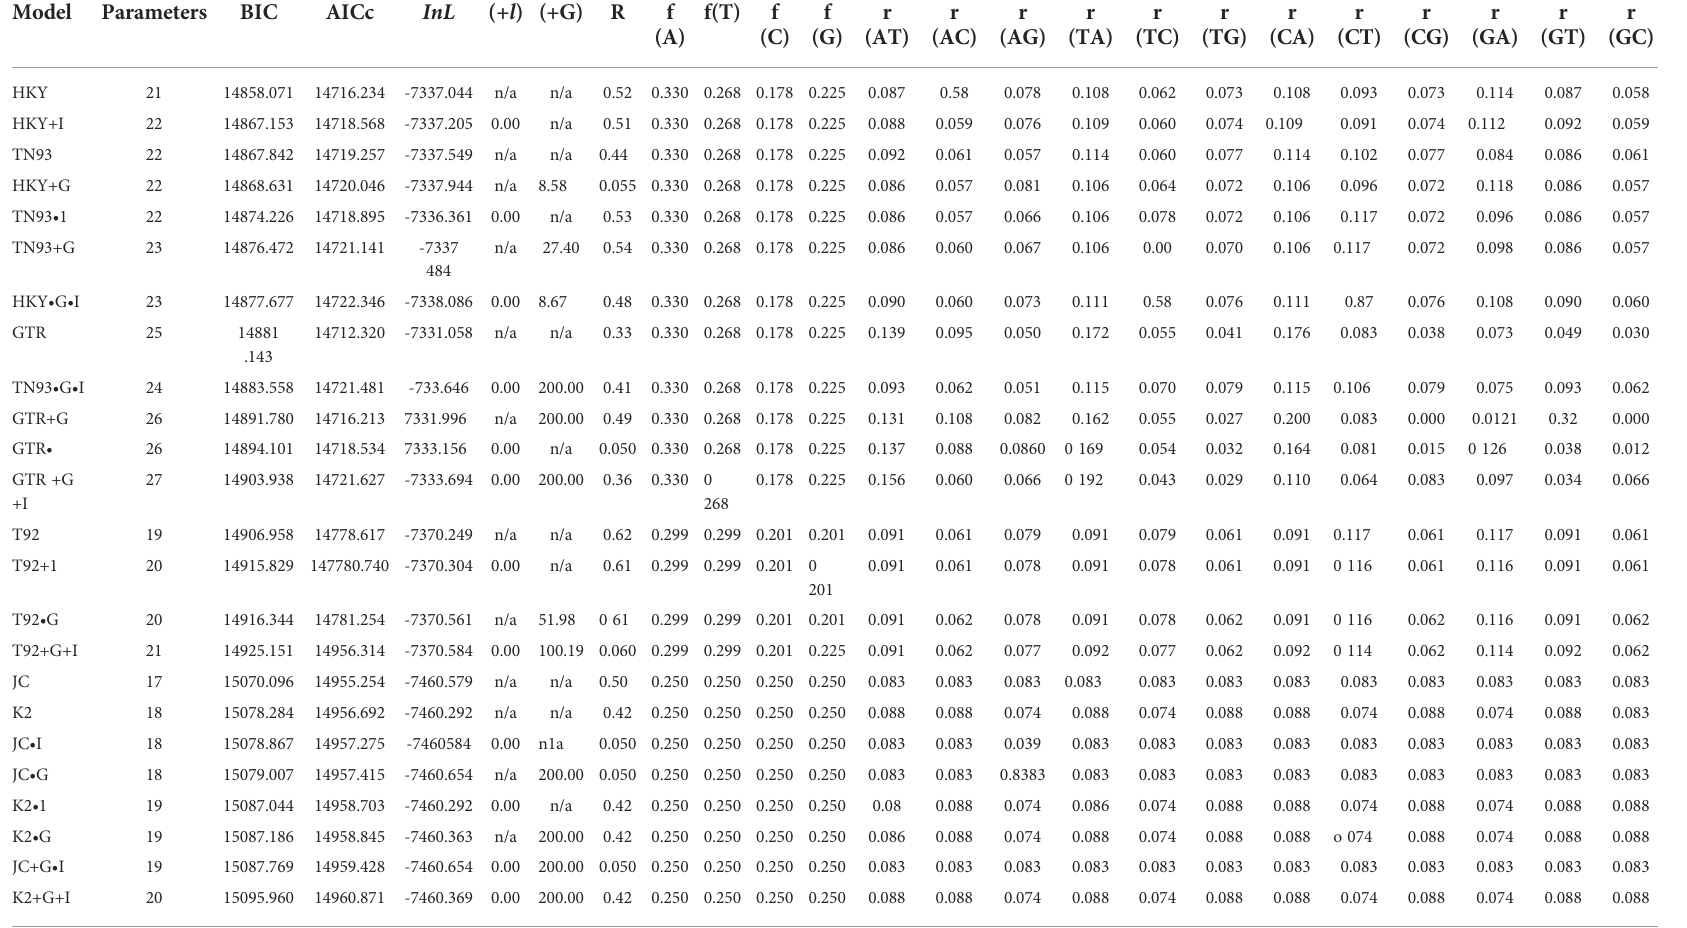
TABLE 12 Maximum likelihood fi ts of 24 different nucleotide substitution models.